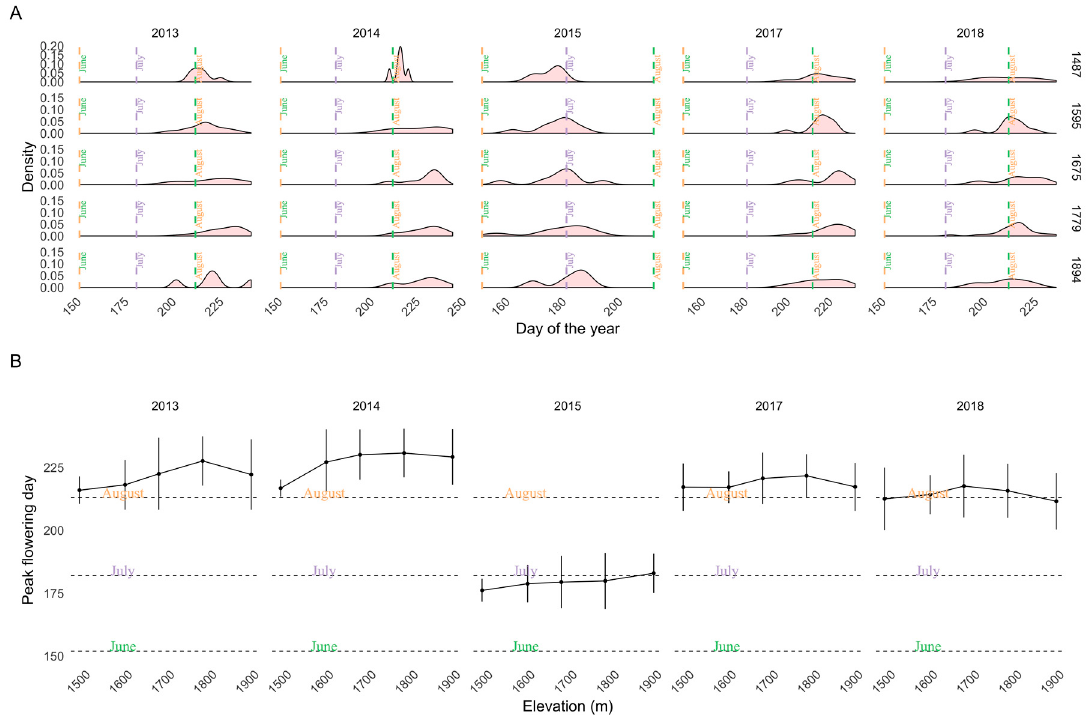
Figure 3. Peak flowering windows using MeadoWatch observations. ( A ) Kernel density of flowering observations by elevation (in meters) and year. ( B ) Estimated flowering windows calculated using mean flowering day and ± 1 SD; error bars indicate length of the flowering window with the dot signifying mean peak flowering day. Note the shift in flowering phenology in 2015, a historically warm year.